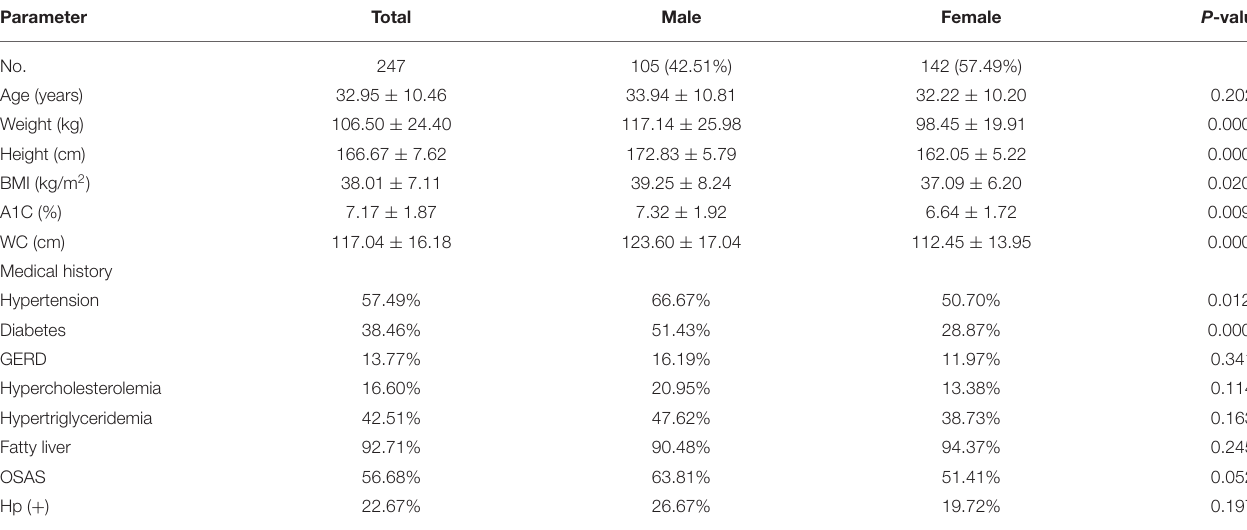
TABLE 1 | The baseline clinical characteristics of study participants before bariatric surgery. Parameter Total